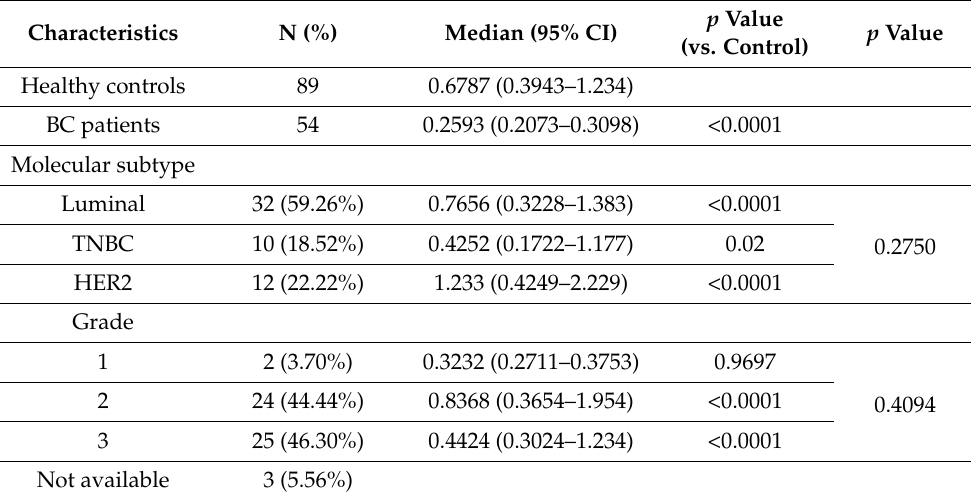
Table 1. Clinicopathological characteristics of BC patients and healthy controls from Cohort